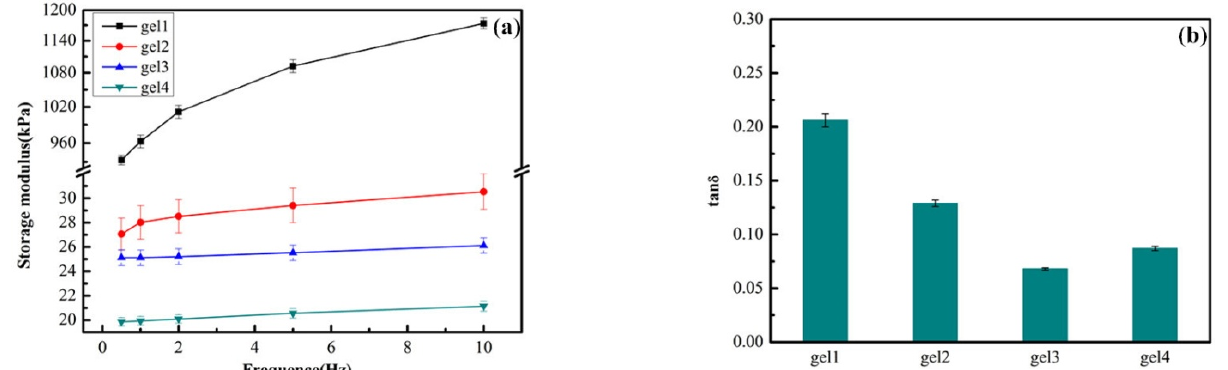
Figure 10. ( a ) The variation curves of the storage modulus of gel1, gel2, gel3, and gel4 with frequency, respectively. ( b ) The loss tangents of gel1, gel2, gel3, and gel4 at a frequency of 10 Hz.